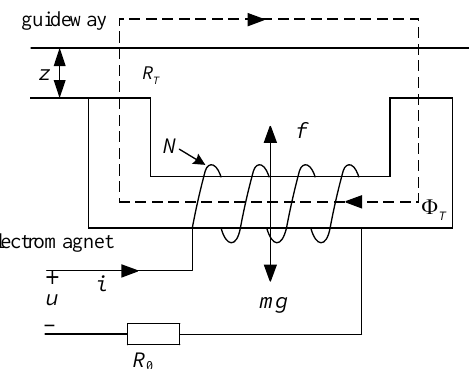
Figure 2. Model of the electromagnetic levitation system.